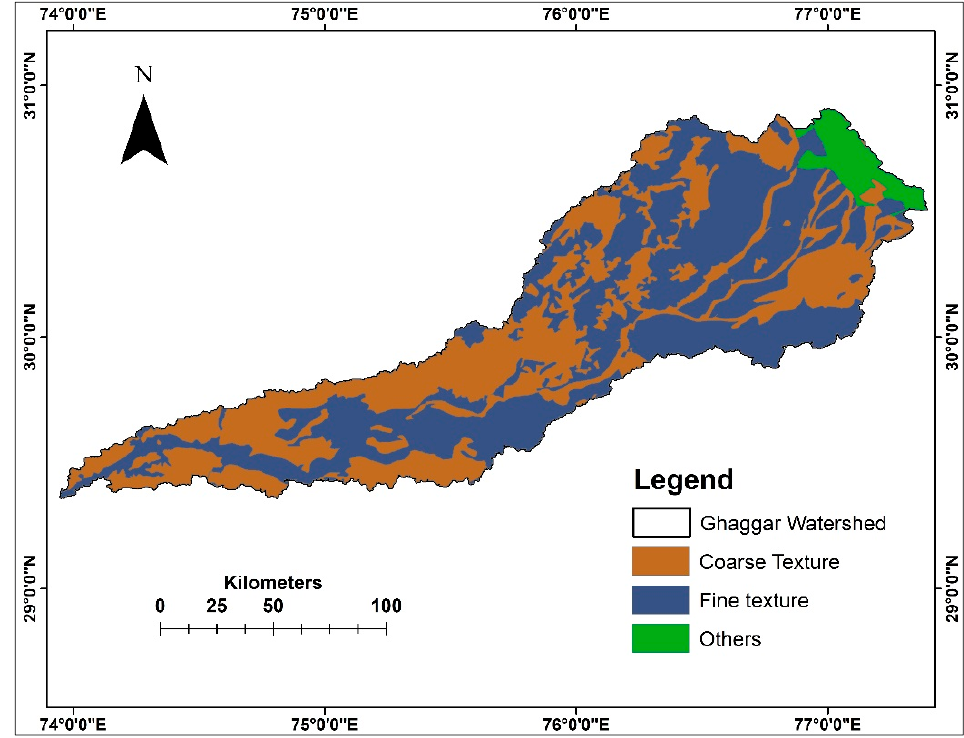
Figure 5. Soil texture map of the study area (Source: National Soil Conservation and Salinization Board).